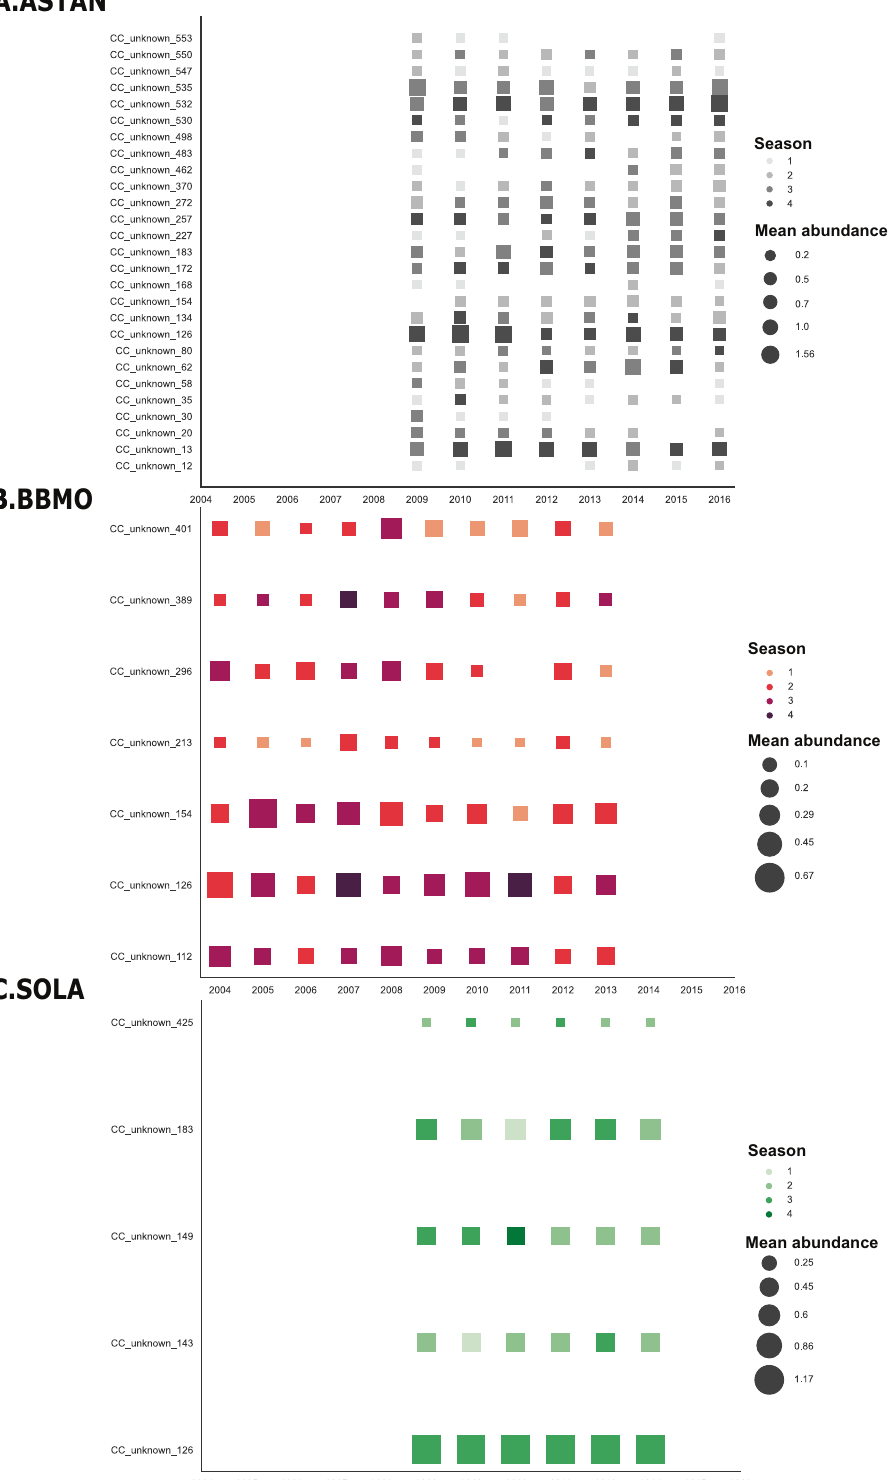
Fig. 4 Annual seasonal prevalence and abundance of rhythmic indicator Syndiniales CCs. The occurrence of CCs selected by the Escouf fi er ’ s equivalent vectors and Lomb-Scargle Periodogram methods was studied across each time-series: A ASTAN (top); B BBMO (middle); C SOLA (bottom). Relative abundance was computed per year as an average value of each month and is represented by square size. Colors indicate the seasonal prevalence of the CC throughout each year and the color gradient indicates the prevalence extent (i.e., 1 season prevalence indicated by the lightest color and 4 seasons indicated by the darkest color of the gradient). A CC is considered prevalent if it is present at least once during each season. Taxonomically unassigned CCs at genus level are indicated by “ unknown ” in the CC ids (y